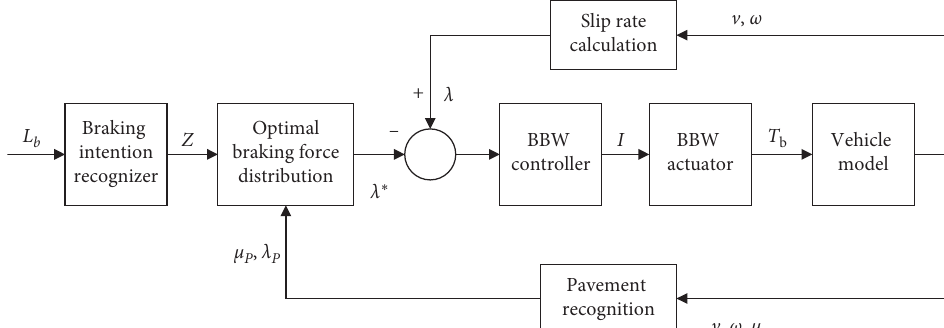
Figure 1: Control structure of the BBW system considering braking comfort. L b is brake pedal opening, Z is output brake intensity, μ p is current road peak adhesion coefficient, λ p is current road optimal slip rate, λ ∗ is current desired slip rate, λ is actual slip rate, I is drive motor armature current, T b is brake disc output torque, ] is vehicle longitudinal speed, ω is angular velocity of wheel rotation, and μ is brake force coefficient.